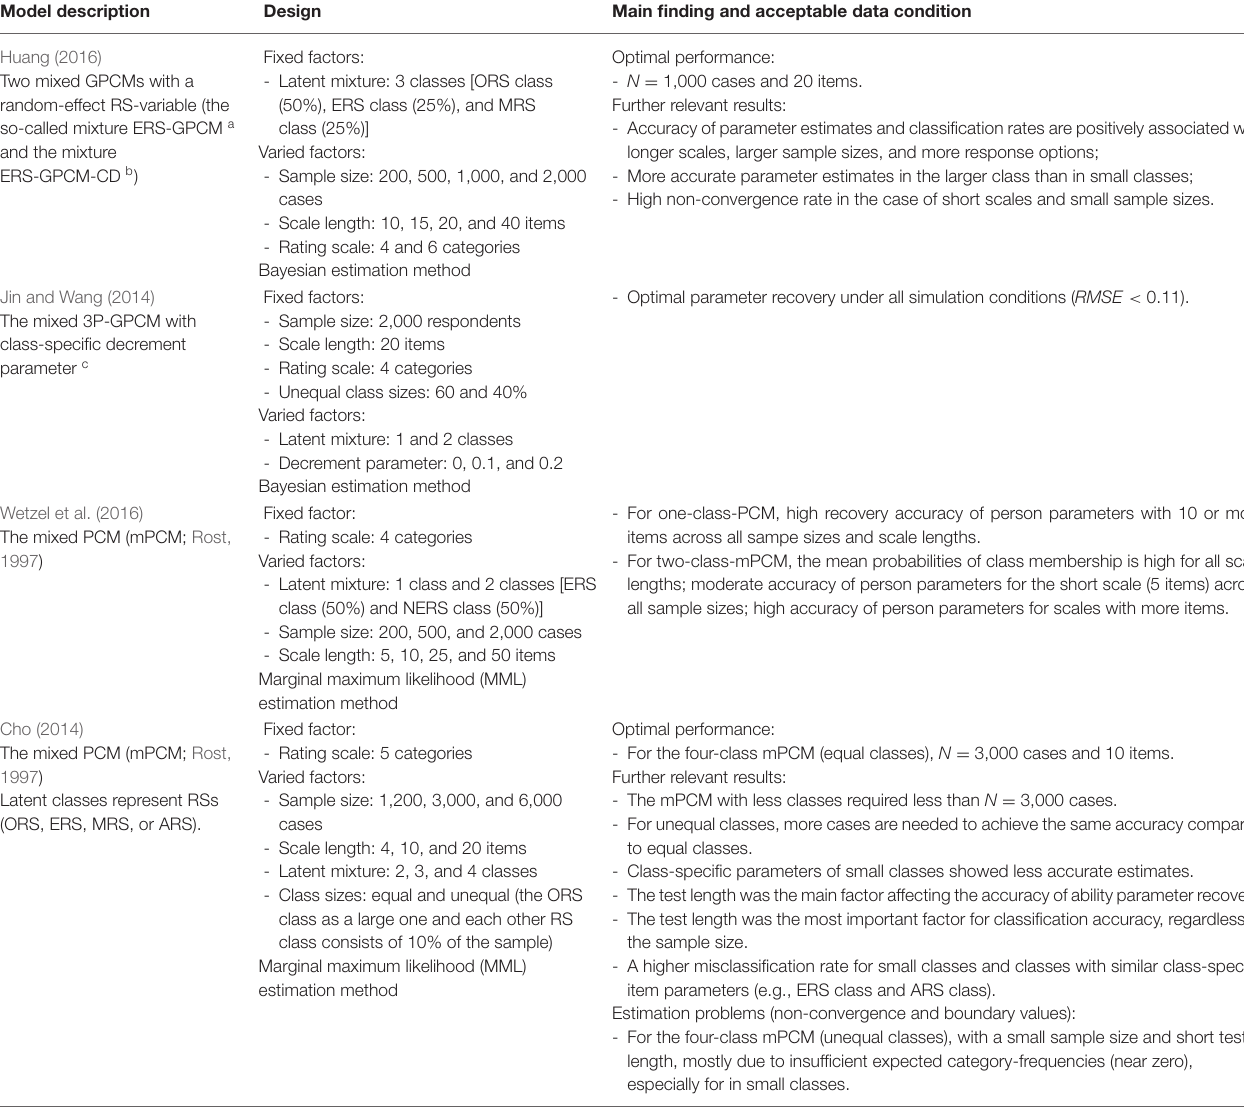
TABLE 1 | Overview of the simulation studies on the performance of mixture polytomous IRT models. Model